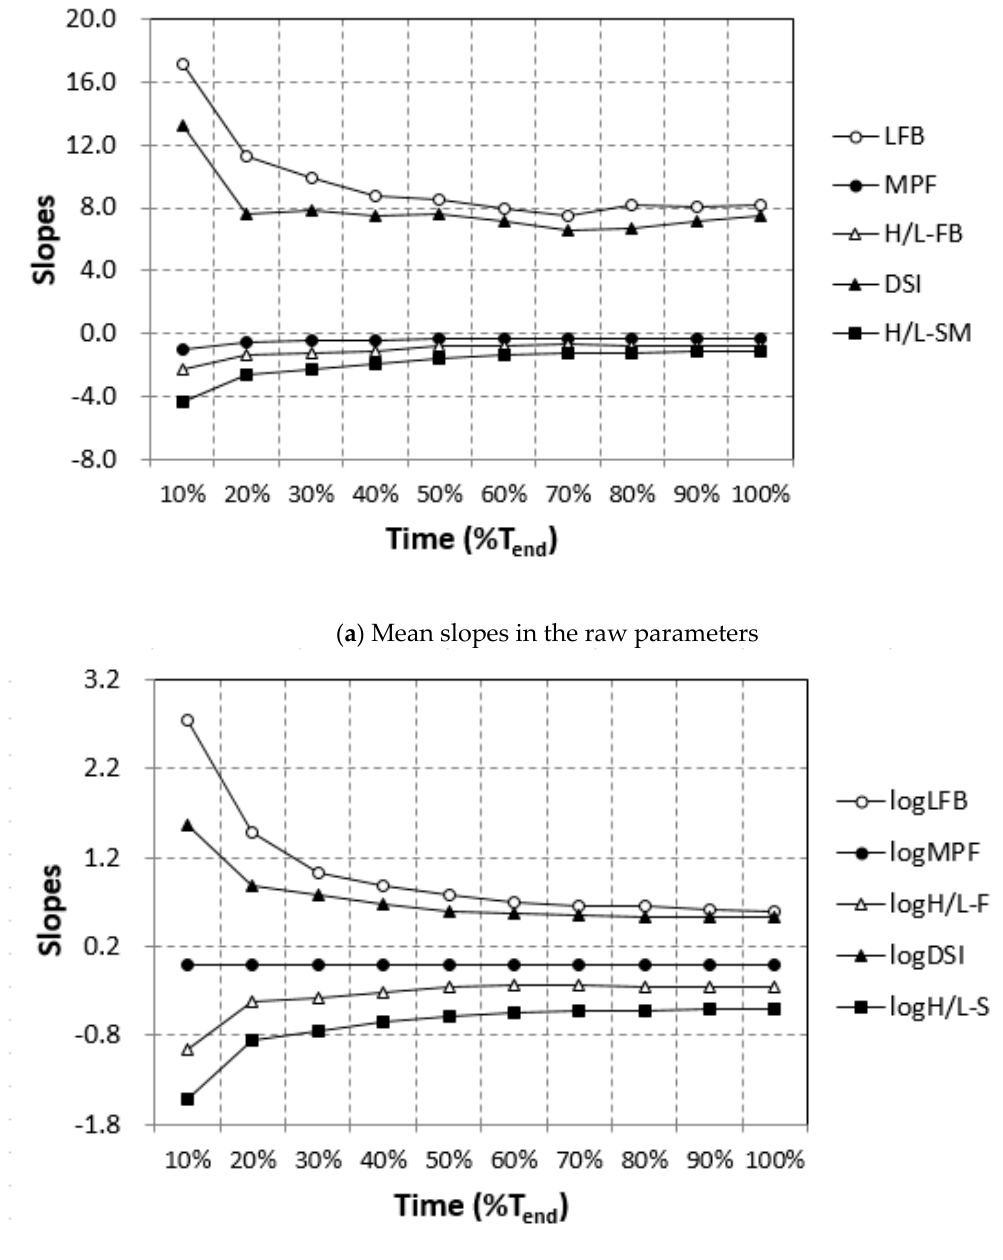
Figure 10. The time series of slopes in the sEMG raw parameters ( a ) and logarithmic ones ( b ) with respect to time as estimated over every 10% of T end (White circle: LFB and logLFB; Black circle: MPF and logMPF; White triangle: H/L-FB and logH/L-FB; Black triangle: DSI and logDSI; Black square: H/L-SM and logH/L-SM). Table 3. Area ratios (mean and S.D.) in the sEMG raw and logarithmic parameters with respect to time as estimated over every 10% of T end (S.D.: standard deviation).